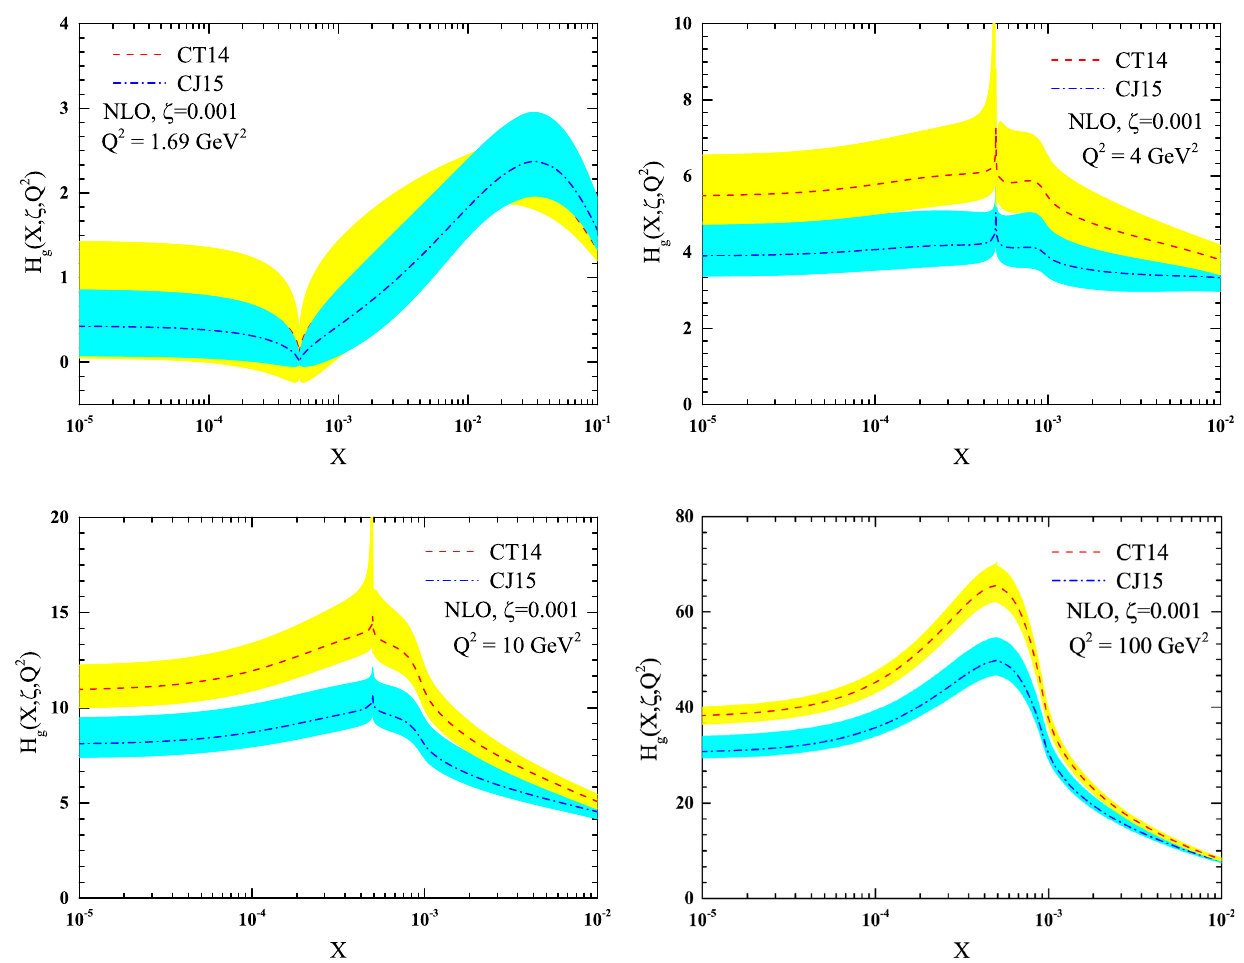
Fig. 2 The gluon GPD H g ( X ,ζ, t = 0 , Q 2 ) as a function of X at ζ = 0 . 001 and Q 2 = 1 . 69, 4, 10 and 100 GeV 2 . See the caption of Fig. 1 for